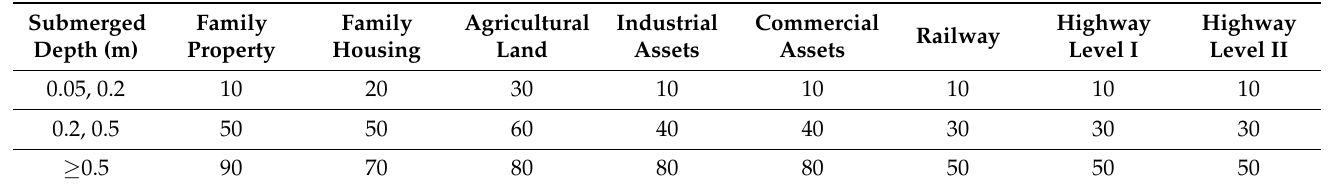
Table 2. Frequency of loss rate assessment for the Cinan Feizuo flood protection area in the percentage of different indicators.